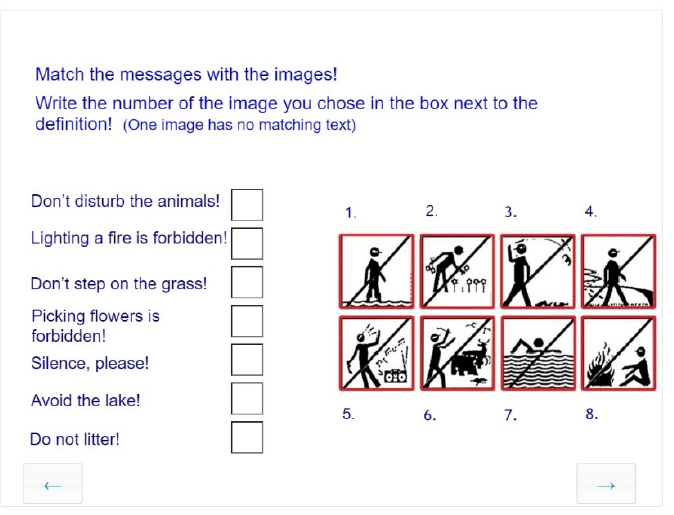
10 of 19 Figure 7. Recognition and differentiation task (task for Grade 5, age 11 years). Visual Interpretation and Recognition of Connections The symbolization task on Figure 8 relates to the subskill of visual interpretation that involves attaching meaning to abstract images. A frequent visual communication problem